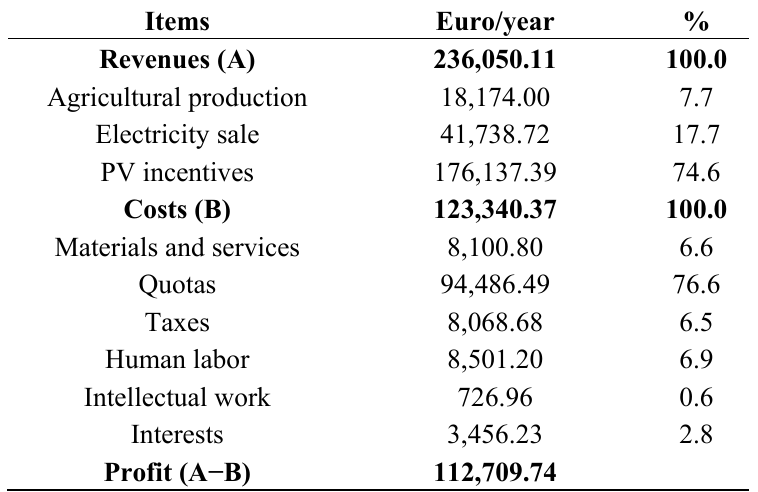
Table 3. Economic results of case study (average annual data referred to a 20-years